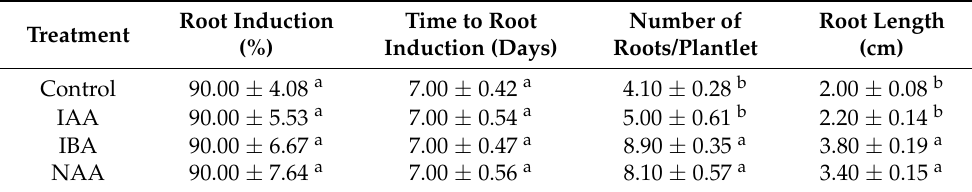
Table 4. Effects of different types of auxins on the in vitro rooting of the feverfew plant.